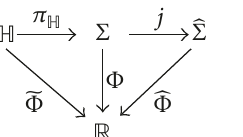
Figure 1: Plot of of 𝜓 ∈ [0, 𝜋] . The value 𝜓 = 0 corresponds to the north pole of 𝑆 2 , while 𝜓 = 𝜋 corresponds to the south